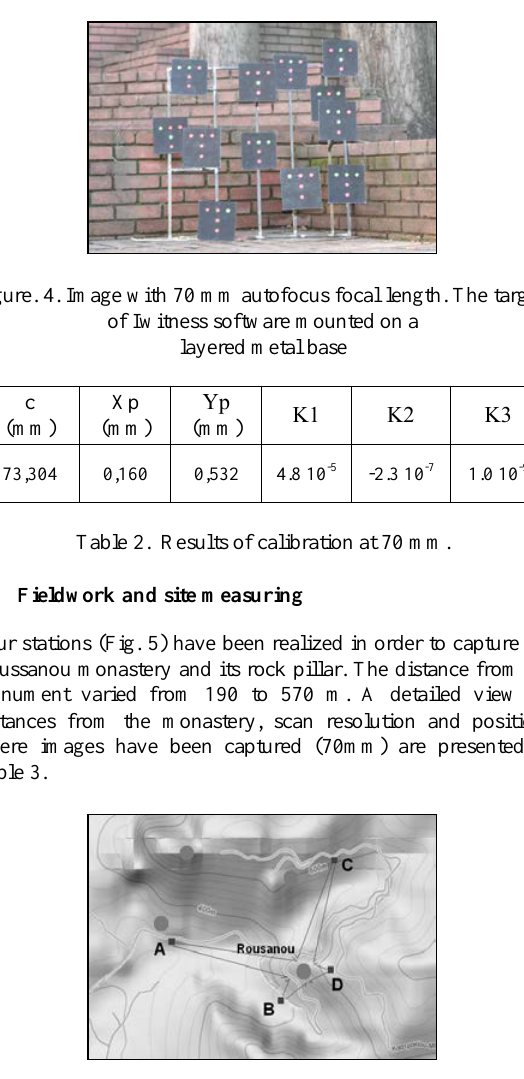
Figure 5. Stations used to capture the Roussanou monastery and its rock